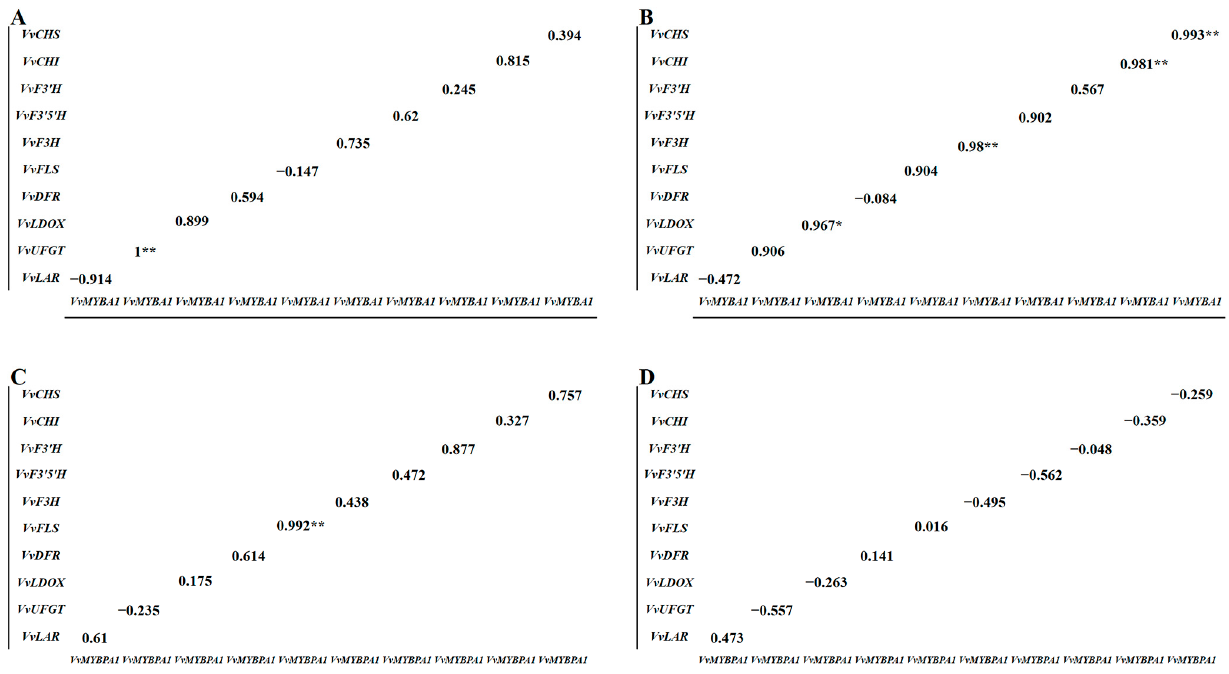
Figure 6. Correlation between anthocyanin synthesis structural genes and VvMYBA1 and VvMYBPA1 regulatory genes in two bud sport groups. ( A ) Correlation between anthocyanin synthesis structural genes and VvMYBA1 regulatory gene in ‘Italia’ vs. ‘Benitaka’ bud sport group; ( B ) ‘Muscat of Alexandria’ vs. ‘Flame Muscat’ bud sport group anthocyanin synthesis structural genes and VvMYBA1 regulatory gene correlation; ( C ) correlation between anthocyanin synthesis structural genes and VvMYBPA1 regulatory gene in ‘Italia’ vs. ‘Benitaka’ bud sport group; ( D ) ‘Muscat of Alexandria’ vs. ‘Flame Muscat’ bud sport group anthocyanin synthesis structural genes associated with VvMYBPA1 regulatory gene. ‘*,**’ represents the two groups of data reached a significant level, ‘*’ represents p < 0.05 , ‘**’ represents p < 0.01.